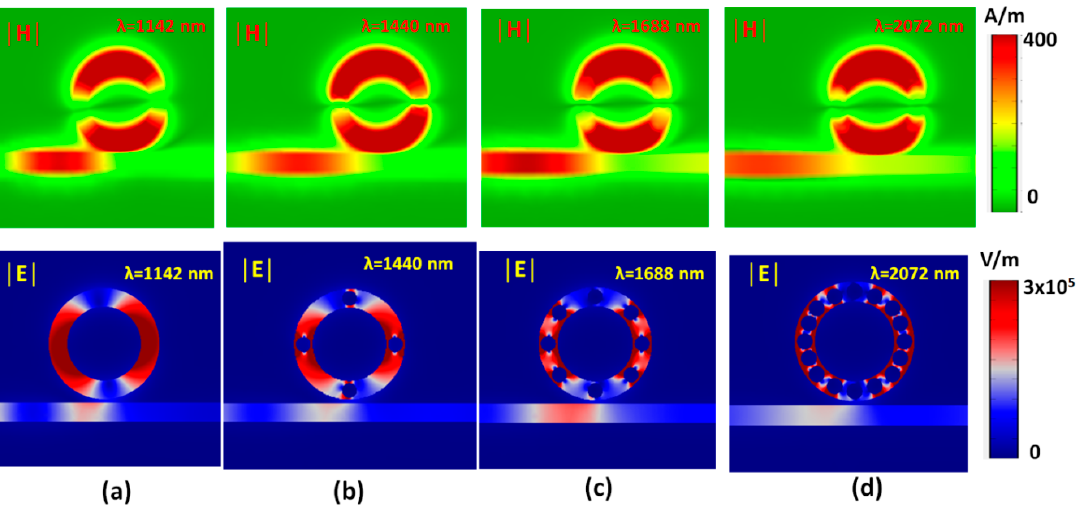
Figure 3. Truncate views of magnetic field intensity ( | H | = (H z2 ) 1 / 2 ) and electric field intensity ( | E | = (E x2 + E y2 ) 1 / 2 ) for the cases ( a ) without silver nanorods (at λ res = 1142 nm), ( b ) with four silver nanorods (at λ res = 1440 nm), ( c ) with eight silver nanorods (at λ res = 1680 nm), and ( d ) with sixteen silver nanorods (at λ res = 2072 nm) for mode 1, respectively.